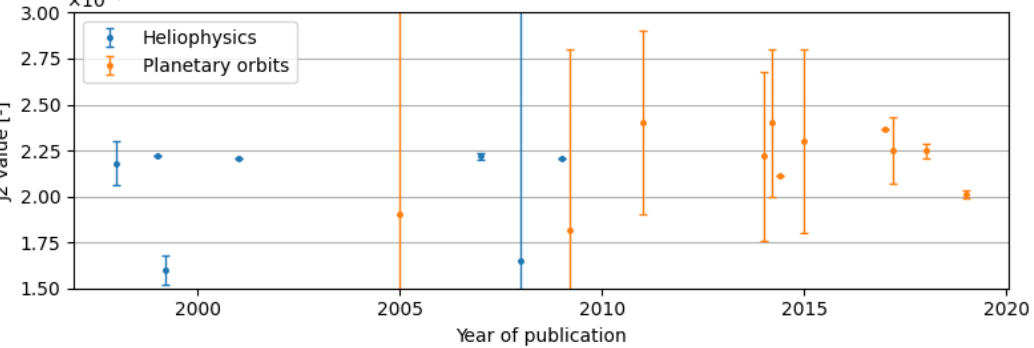
Figure 1. Selected attempts to determine J 2 (cid:12) over the last 25 years. Error bars indicate the 2 σ uncertainty, corresponding to a 95% confidence level. Where no error bars are drawn, uncertainties were not provided. All entries in this plot are provided at the end of the paper in Table